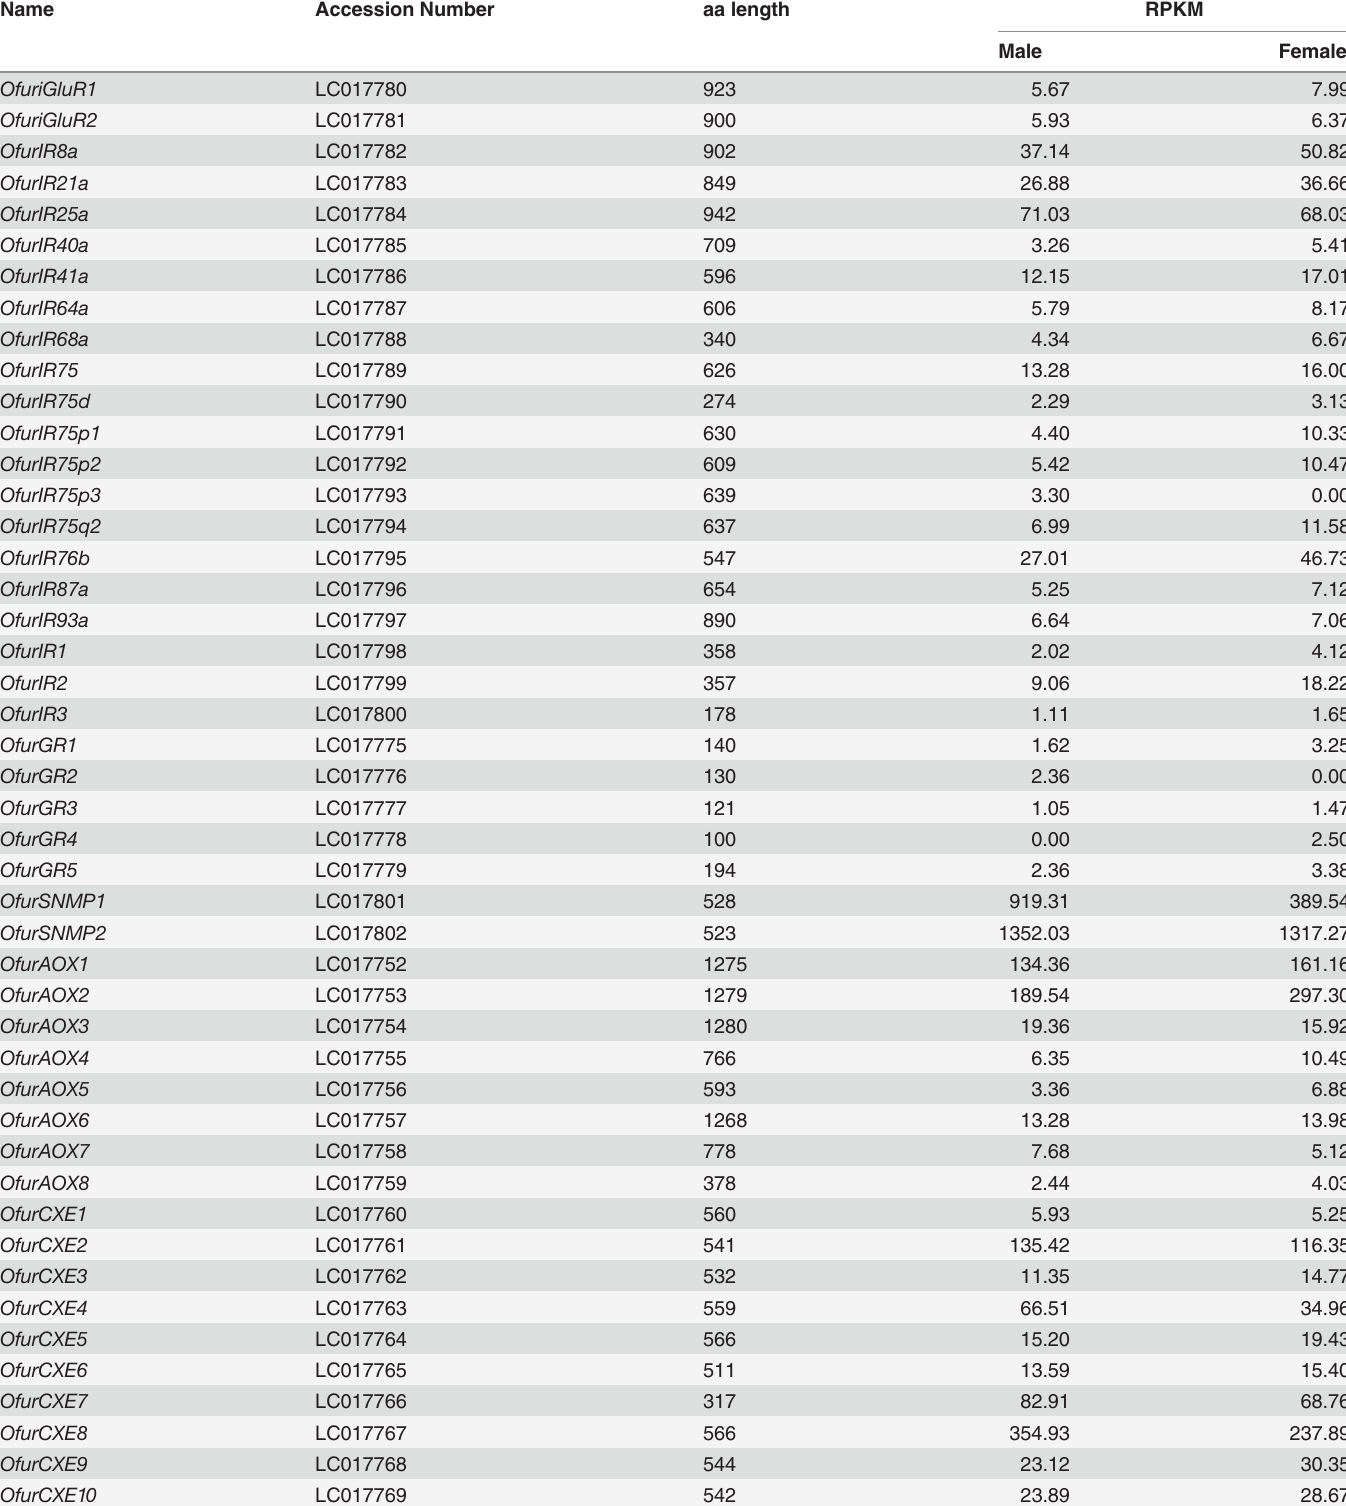
Table 6. List of other candidate genes involved in olfactory perception in O . furnacalis